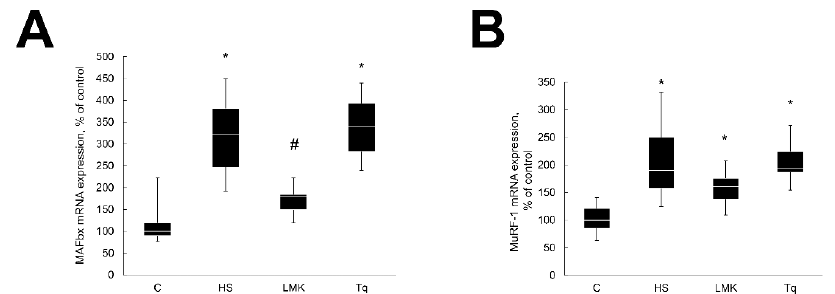
Figure 3. Evaluation of the MAFbx ( A ) and MuRF1 ( B ) mRNA expression in soleus muscles of nontreated control rats ( C ), rats after 3 days of unloading (HS), 3 days HS with LMK-265 inhibitor (HSLMK) or HS with Tq inhibitor (HSTq). Values are normalized to the levels of GAPDH mRNA expression in each sample. n = 8. * indicates a significant difference from the control, p < 0.05; # indicates a significant difference from the HS, p < 0.05.